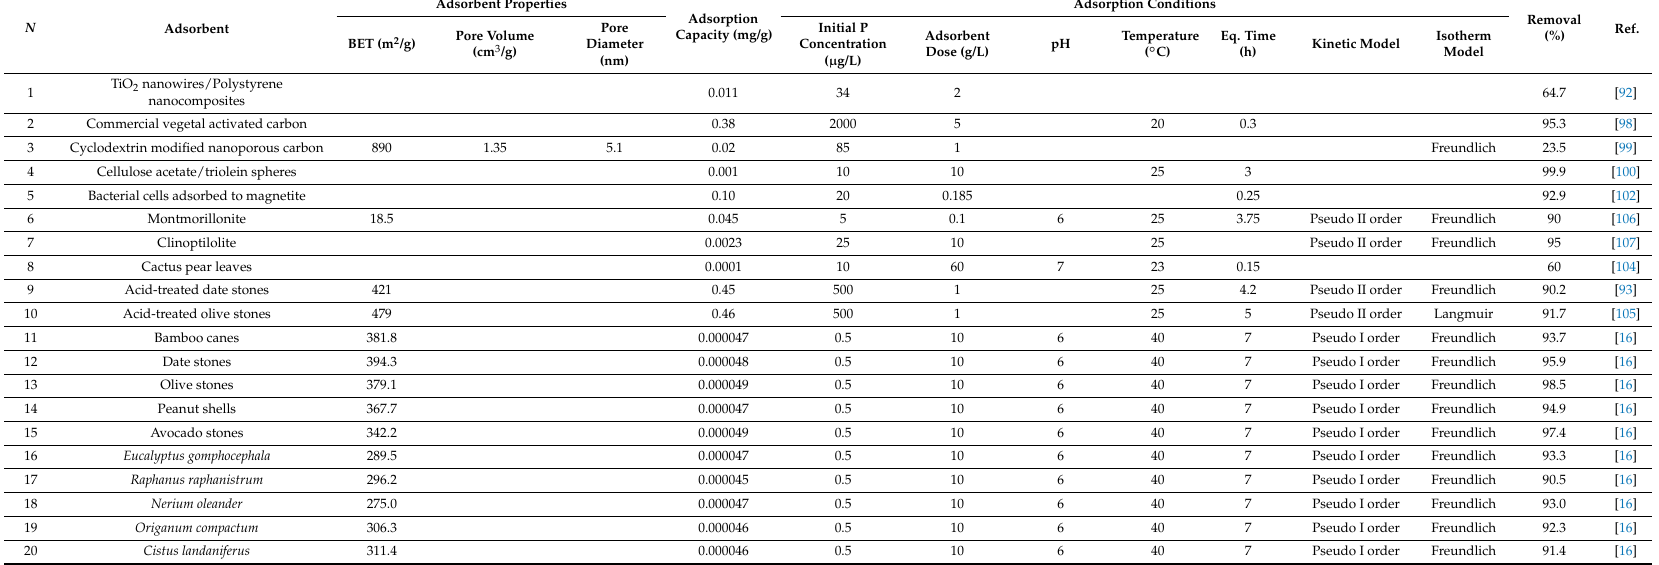
Table 13. Nanofibrous adsorbent properties and adsorption conditions for the removal of Aldrin.